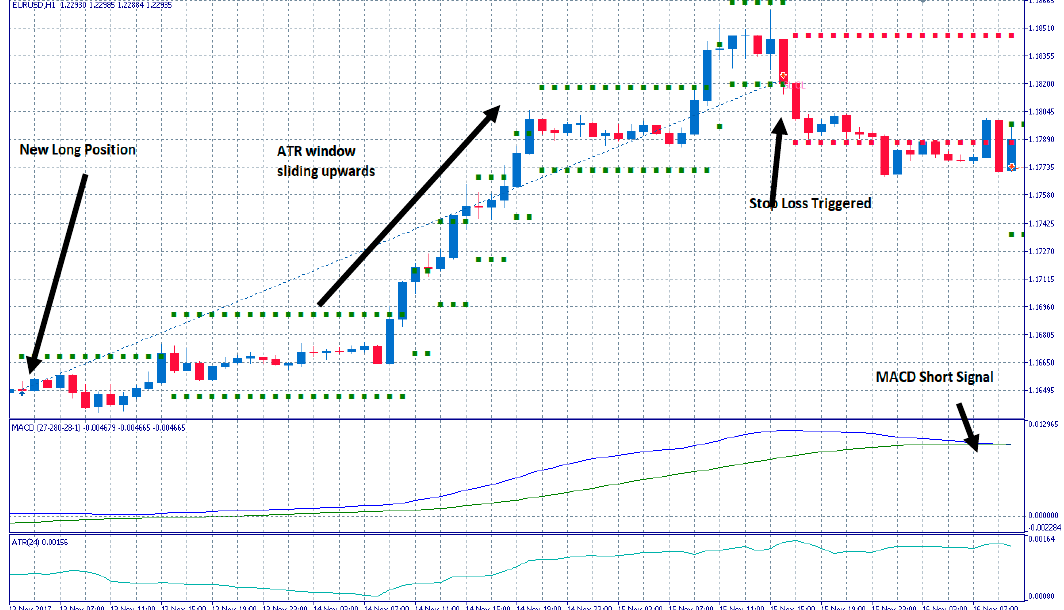
Figure 4. A segment from an MACD Expert Advisor’s trading on EURUSD. The green dots show how the ±2 × ATR(24) zone slides upwards as the price moves to more profitable values. Eventually, a stop loss is triggered and the position is closed at a higher price than the one we would have in the event of waiting for the next MACD signal.